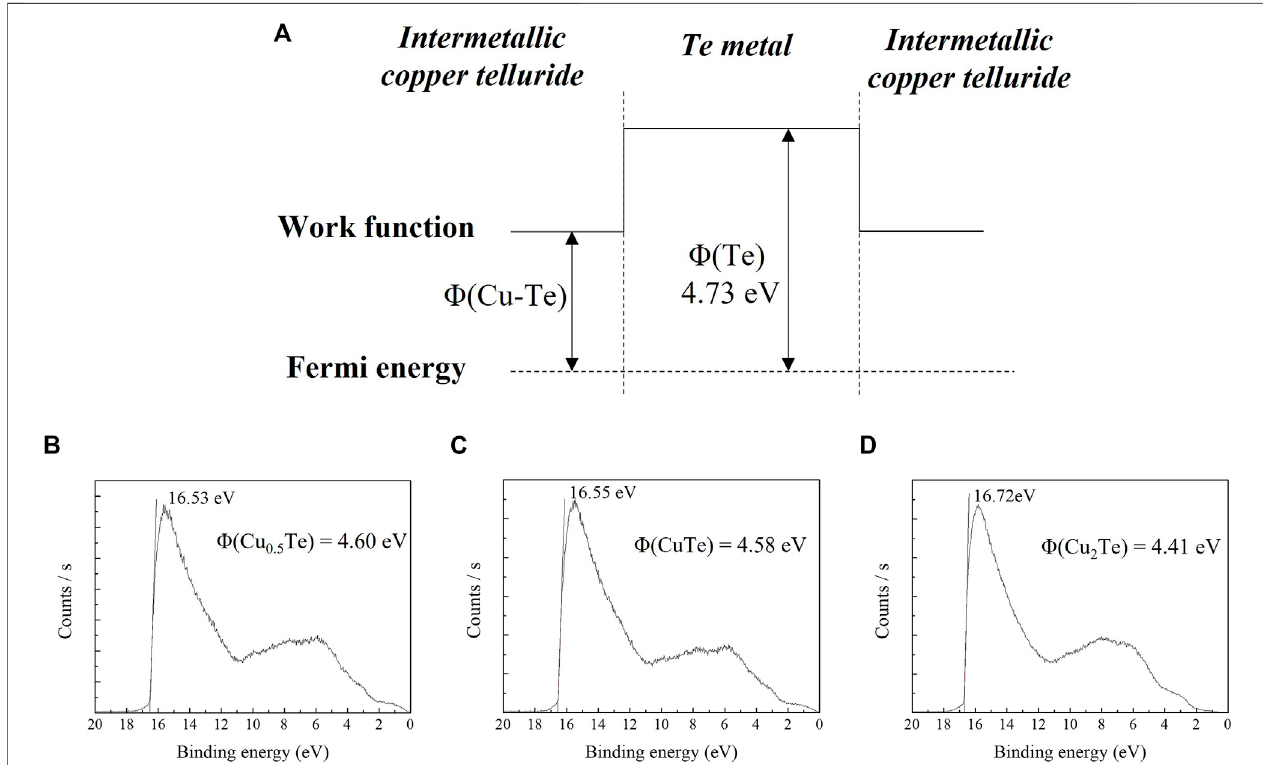
Frontiers in Chemistry |